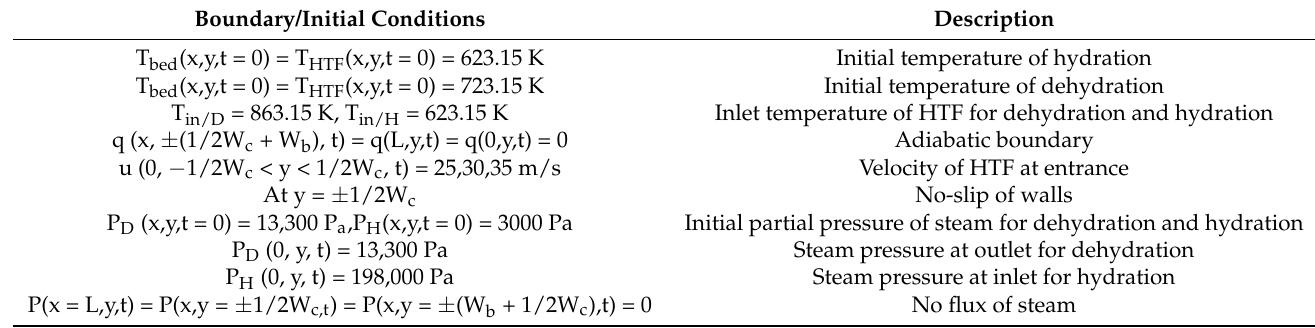
Table 2. Boundary/initial conditions for governing